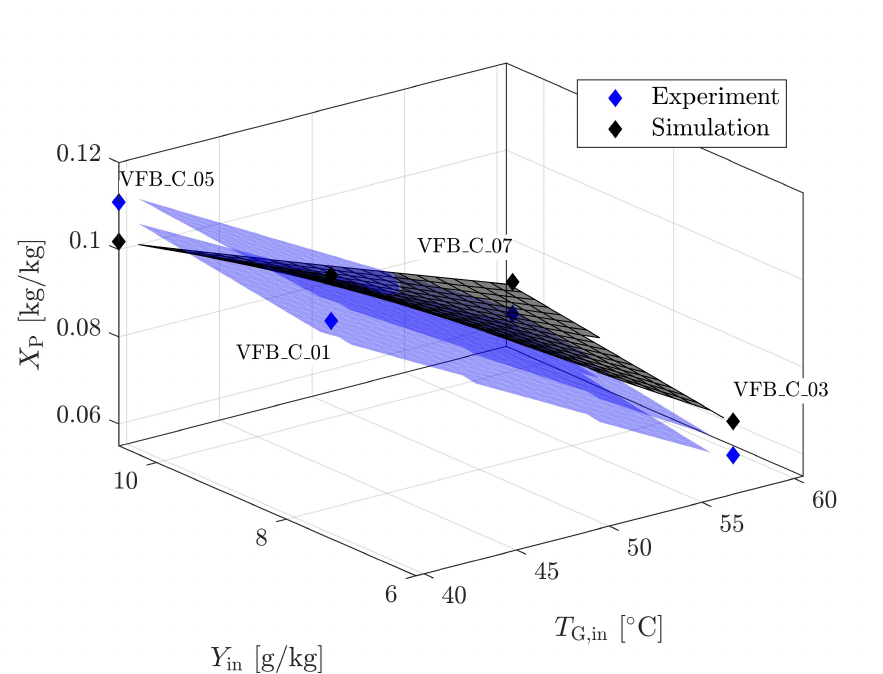
Figure 12. Comparison of measurements and model predictions of particle moisture content ( X P ), plotted against drying temperature ( T G,in ) and inlet moisture content of air ( Y in ), in the VFB pilot- plant-scale dryer for Cellets. The dark gray area designates model predictions; light blue areas indicate the upper and lower boundary of measurement errors. Detailed information about the process conditions of the represented data points is given in Table 2.